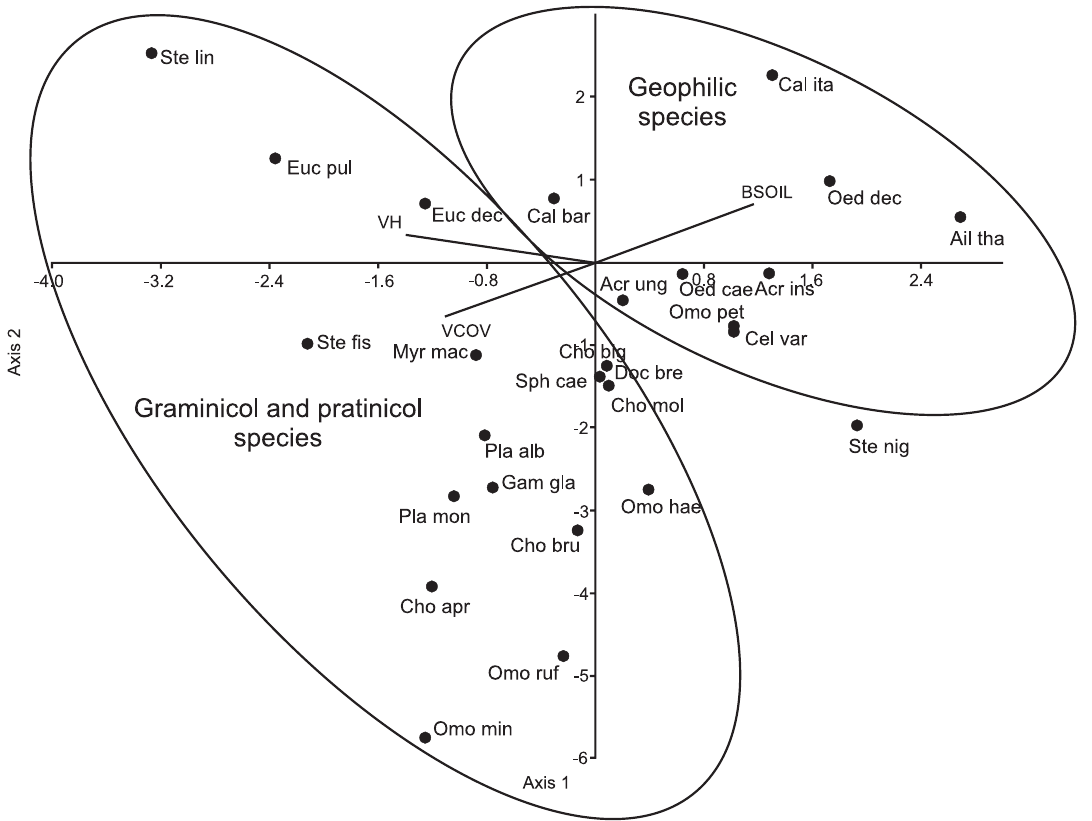
Fig. 7. CCA ordination based on Orthoptera data and environmental parameters (VCOV: total vegetation cover; BSOIL: percentage of bare soil; VH: height of the vegetation). Abbreviations of species names: Acr ins: Acrotylus insubricus ; Acr ung: Acrida ungarica ; Ail tha: Aiolopus thalassinus ; Cal bar: Calliptamus barbarus ; Cal ita: Calliptamus italicus ; Cel var: Celes variabilis ; Cho apr: Chorthippus apricarius ; Cho big: Chorthippus biguttulus ; Cho bru: Chorthippus brunneus ; Cho mol: Chorthippus mollis ; Doc bre: Dociostaurus brevicollis ; Euc dec: Euchorthippus declivus ; Euc pul: Euchorthippus pulvinatus ; Gam gla: Gampsocleis glabra ; Mon mon: Montana montana ; Myr mac: Myrmele- otettix maculatus ; Oed cae: Oedipoda caerulescens ; Oed dec: Oedaleus decorus ; Omo hae: Omocestus haemorrhoidalis ; Omo min: Omocestus minutus; Omo pet: Omocestus petraeus ; Omo ruf: Omocestus rufipes ; Pla alb: Platycleis albopunctata ; Sph cae: Sphingonotus caerulans ; Ste fis: Stenobothrus fischeri ; Ste lin: Stenobothrus lineatus ; Ste nig: Stenobothrus nigromaculatus